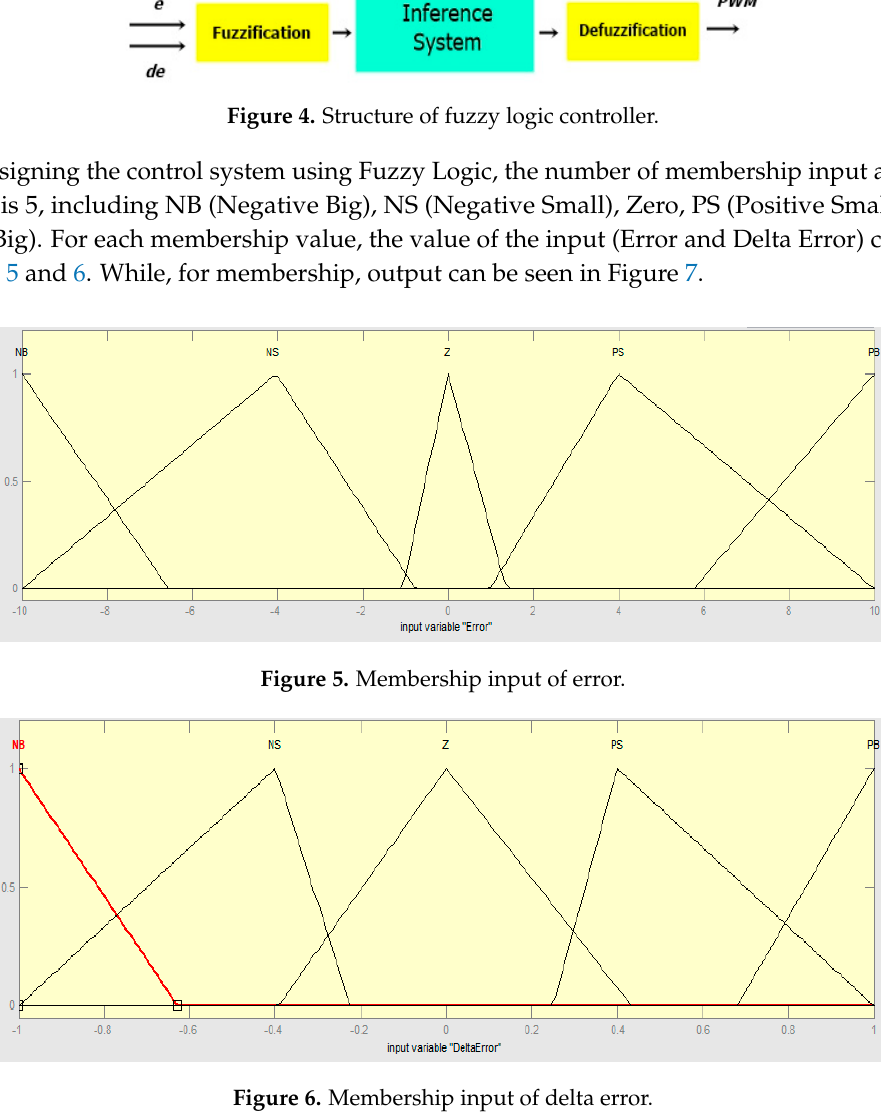
Figure 6. Membership input of delta error.